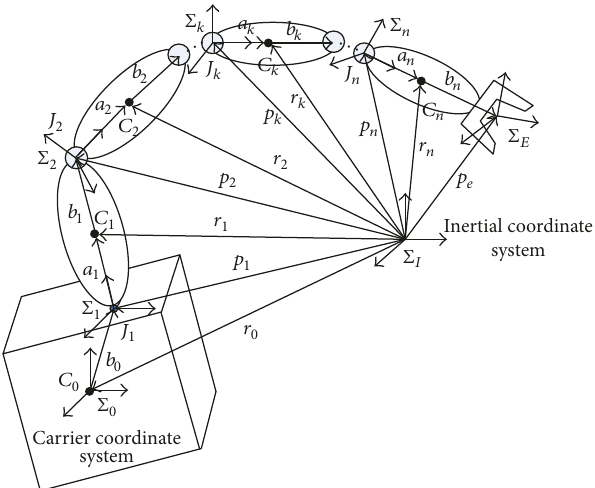
Figure 1: The 𝑛 -DOF free-floating space manipulator vector model.